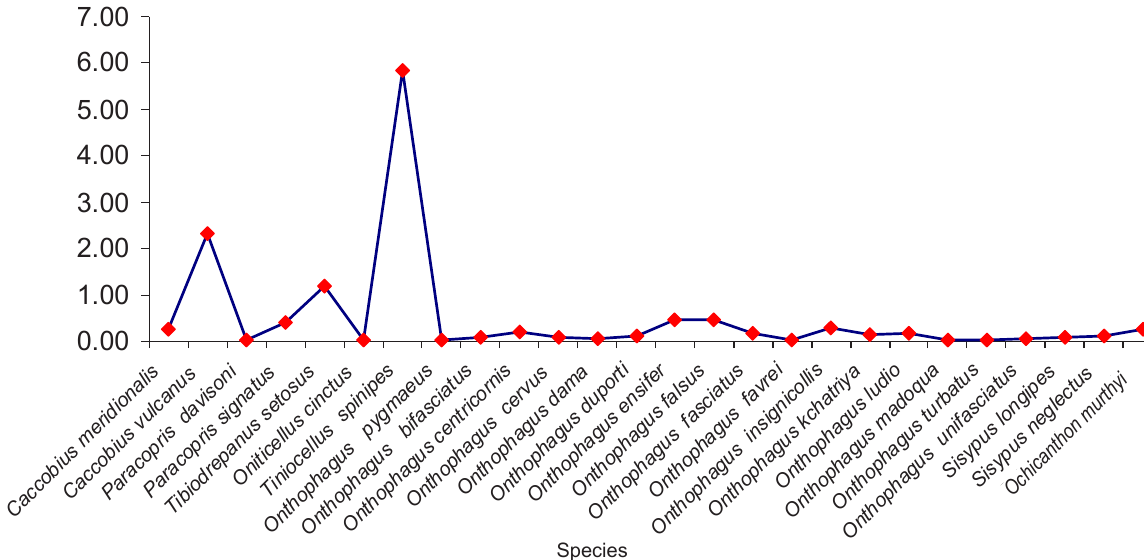
Figure 1. Rank abundance plot of dung beetles in the fragmented urban agricultural habitat during 2008–09